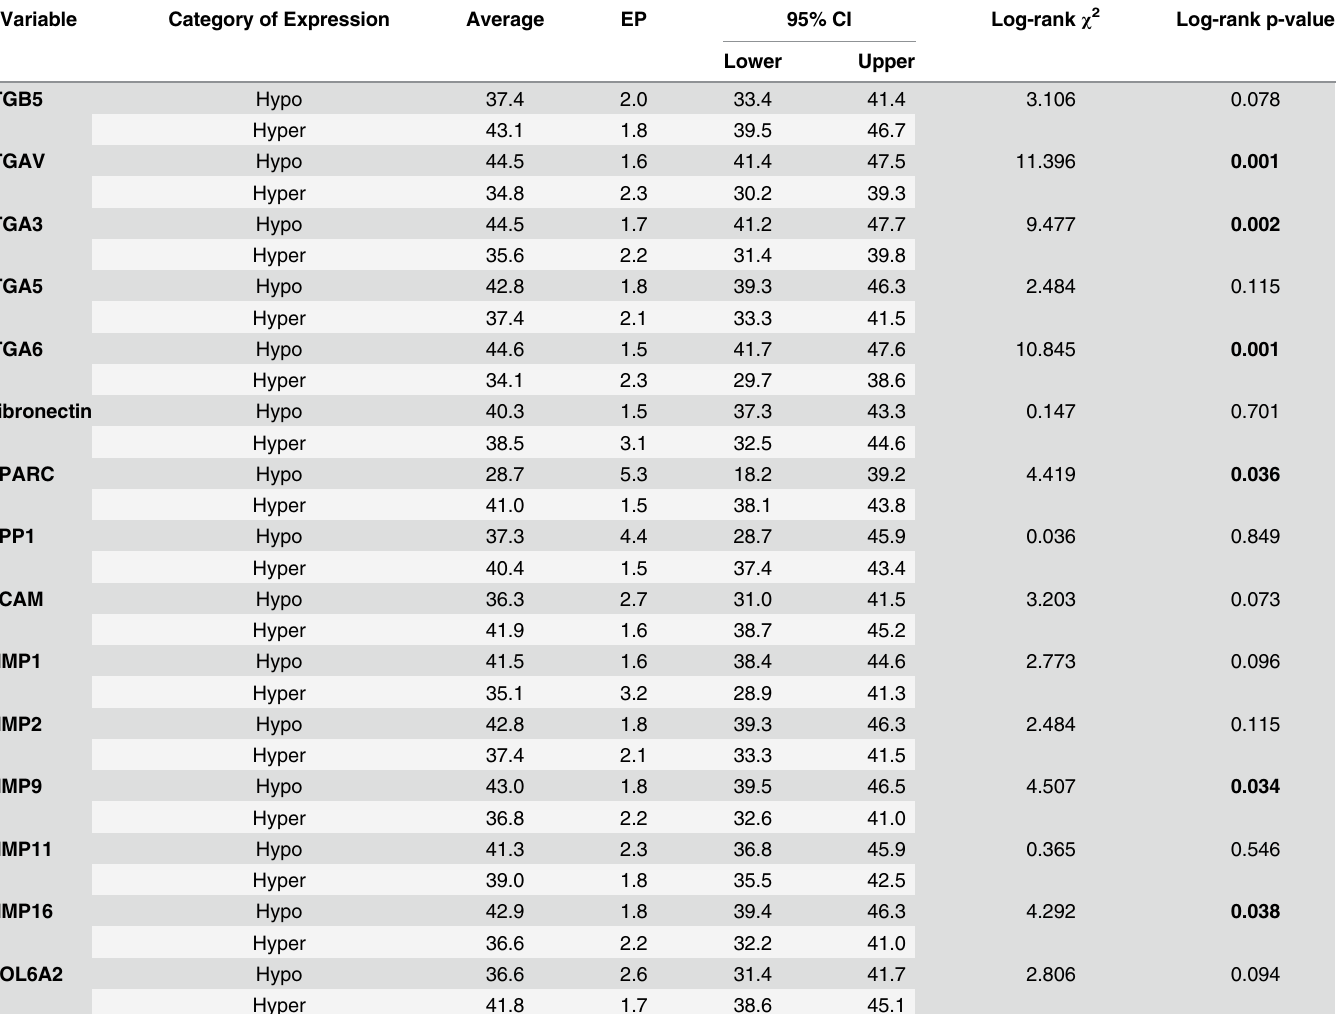
Table 2. Analysis of GS in relation to of the ECM markers